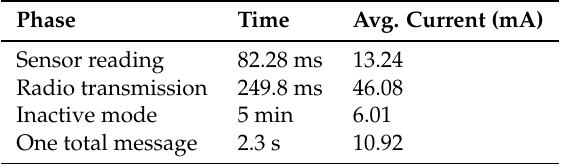
Table 6. Power consumption analysis for LoRaWAN